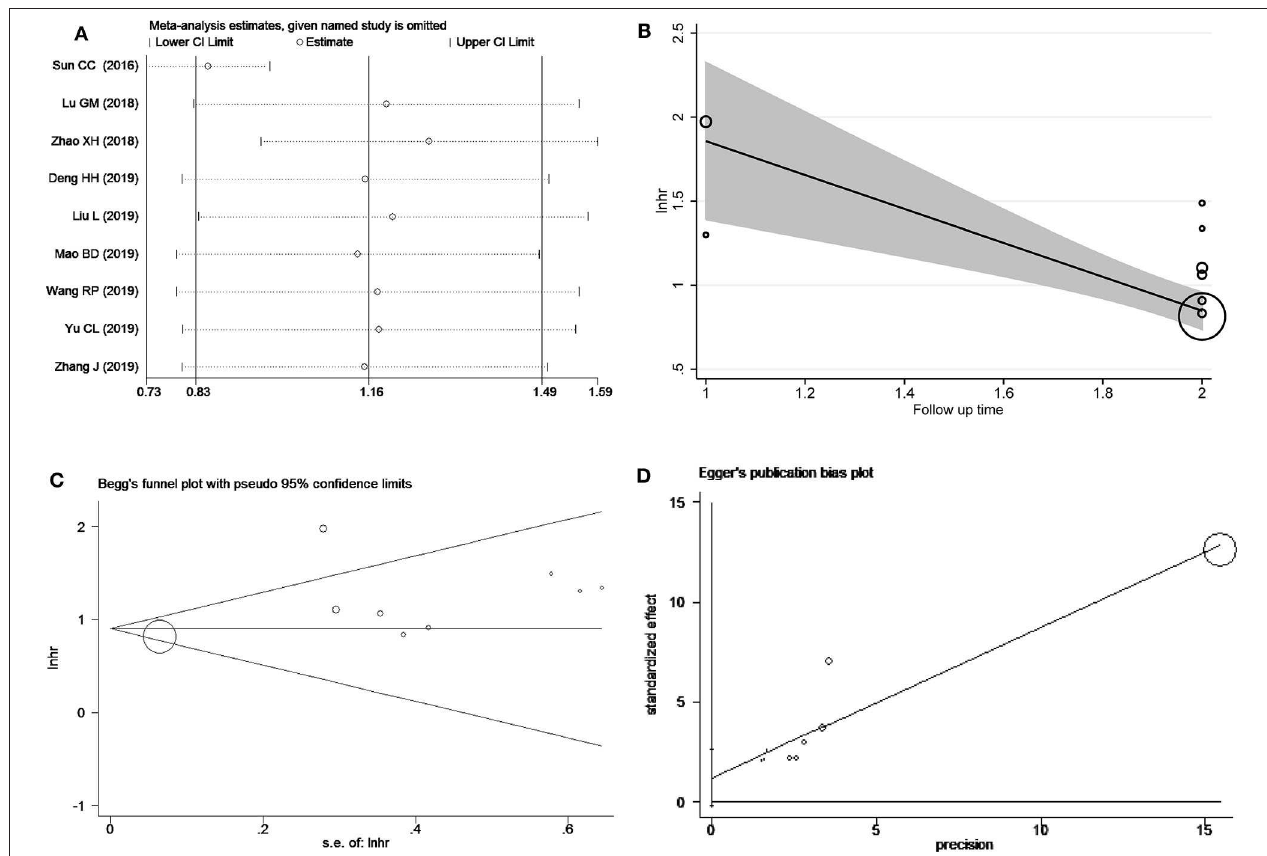
FIGURE 3 | Heterogeneity analysis for the meta-analysis of OS including sensitivity analysis (A) , Bgger’s test (B) , Egger’s test (C) and meta-regression (D) .